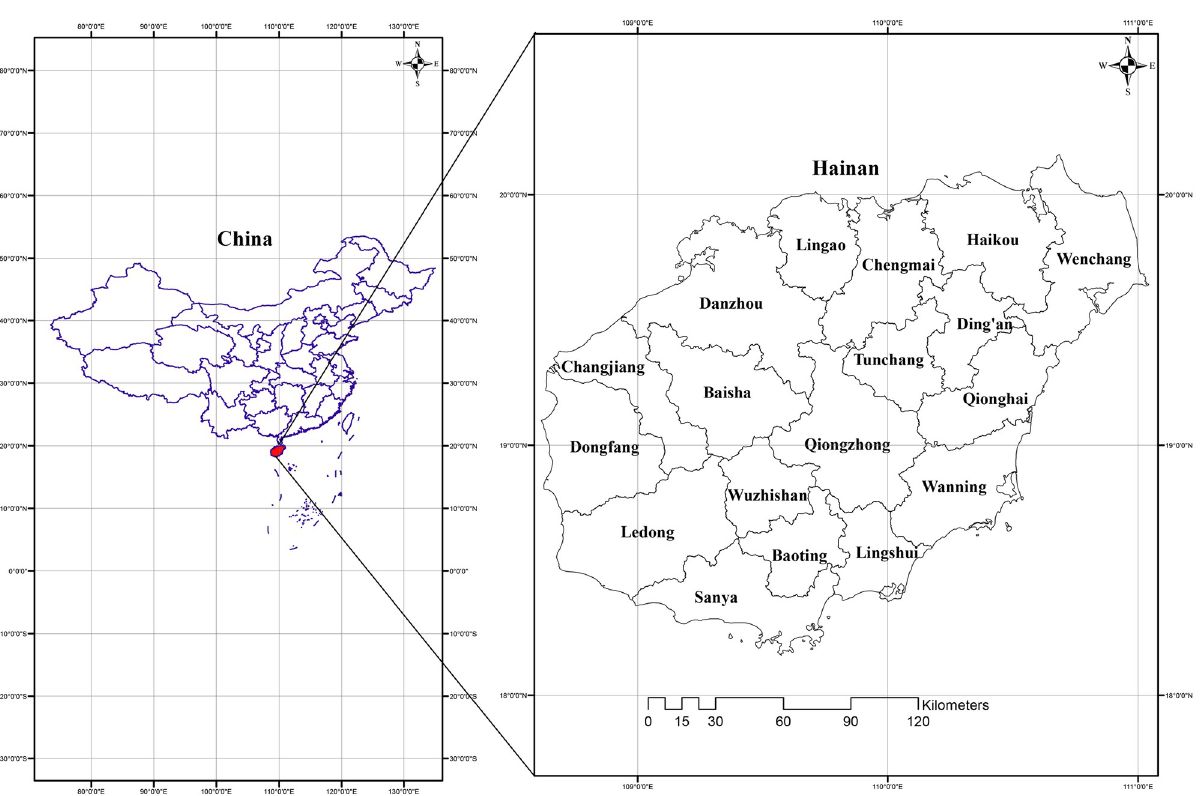
Fig 1. The 18 included administrative units (city or county) of Hainan,